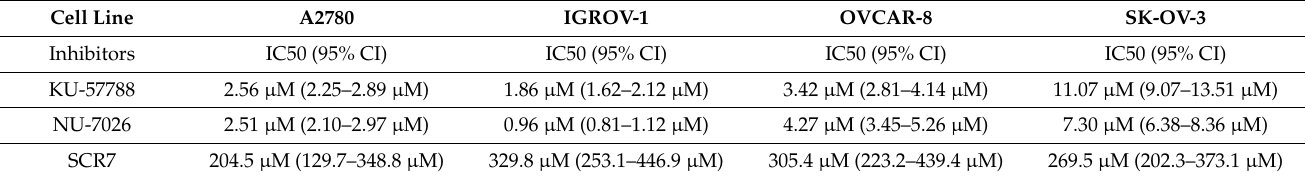
Table 1. IC50 values for NHEJi. Best-fit values for IC50 values and interval in which IC50 is included. These values were calculated using GraphPad Prism software (version